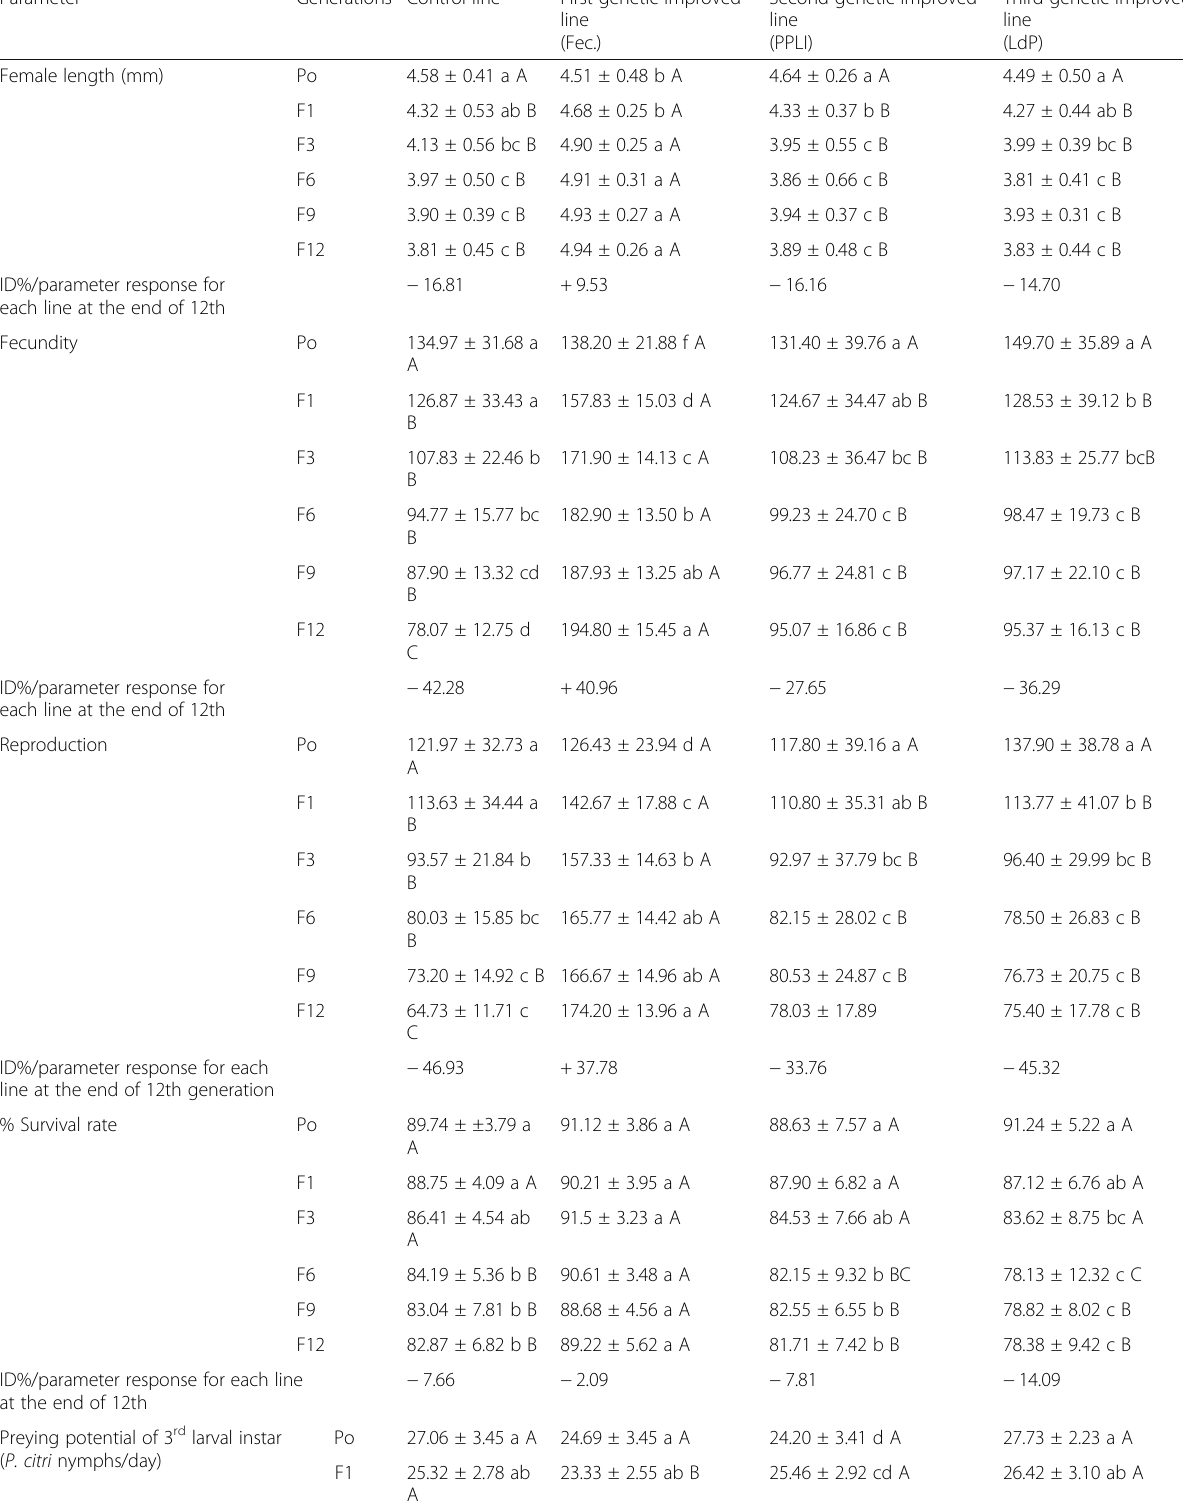
Table 1 Changes in morphobiological parameters (mean ± SD) of the predator C. montrouzieri for 12 inbreeding generations using three genetic improved